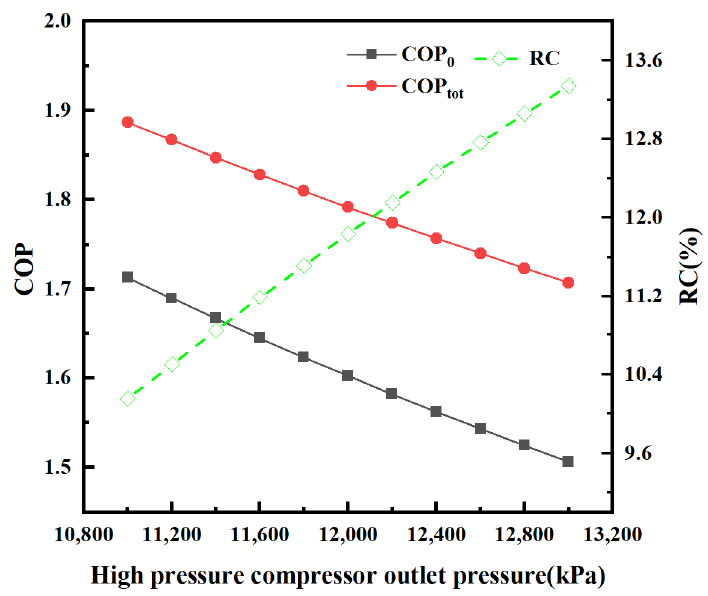
Figure 7. COP of the coupling cycle and CO 2 cycle varied with the outlet pressure of a high-pressure compressor.